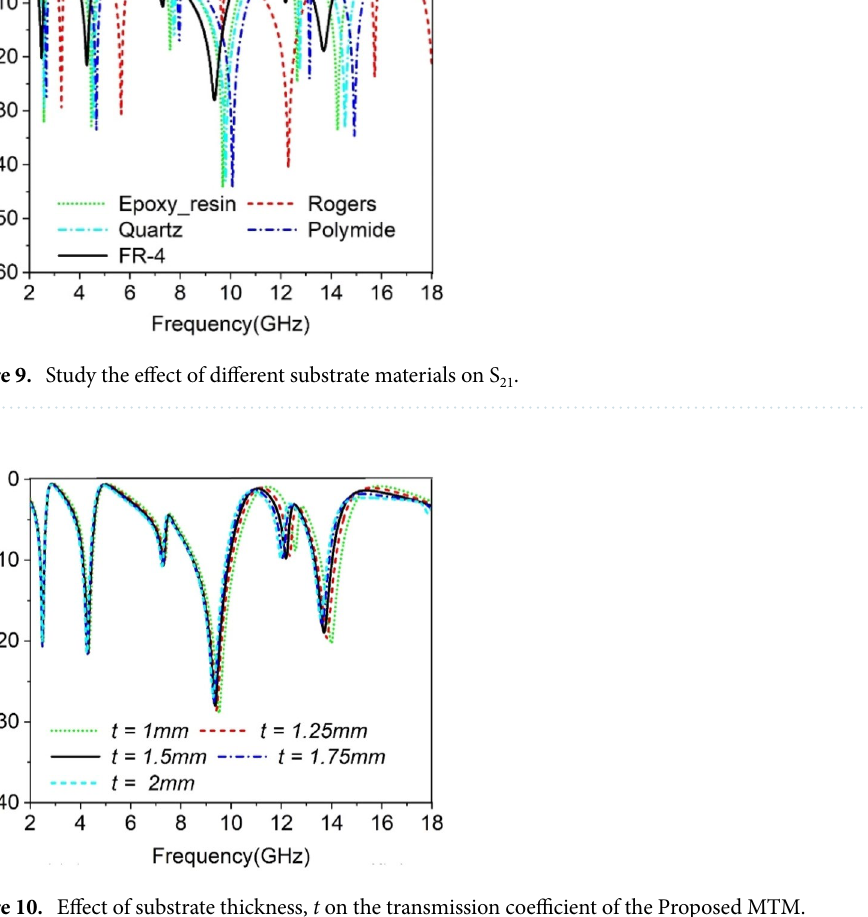
Figure 10. Effect of substrate thickness, t on the transmission coefficient of the Proposed